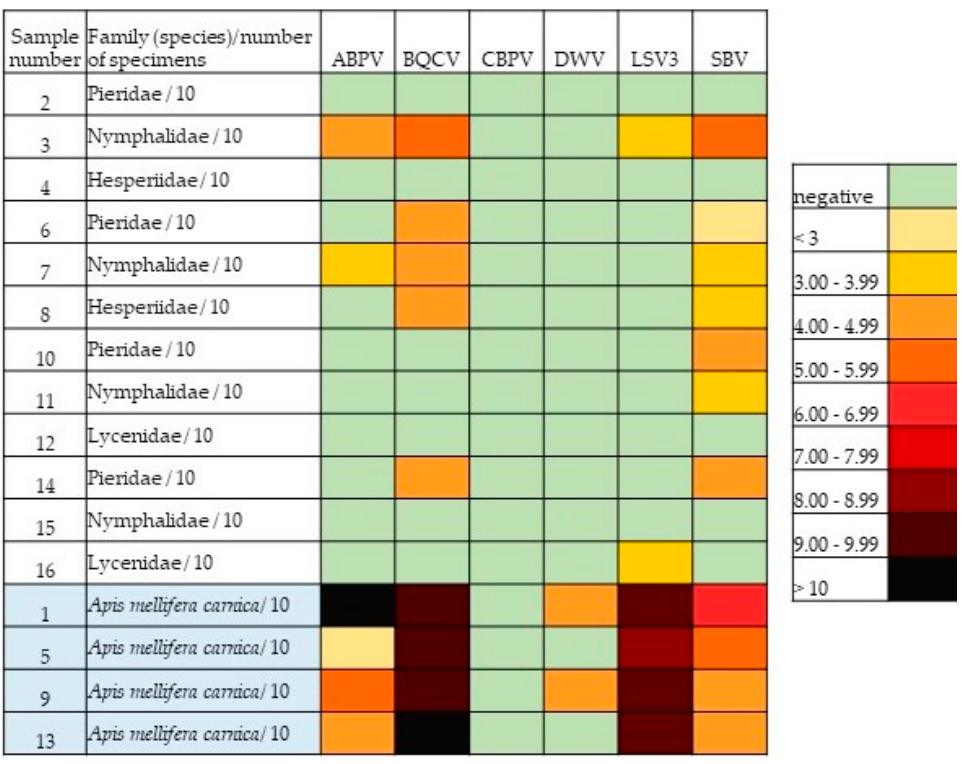
Figure 3. Heatmap analysis of the distribution of the detected viral load in quantitative real-time RT-PCR (number of viral copies for each positive sample converted to log 10 ). Green represents a negative result. Light yellow and yellow represent weak positive results, and dark red and black represent strong positive results.